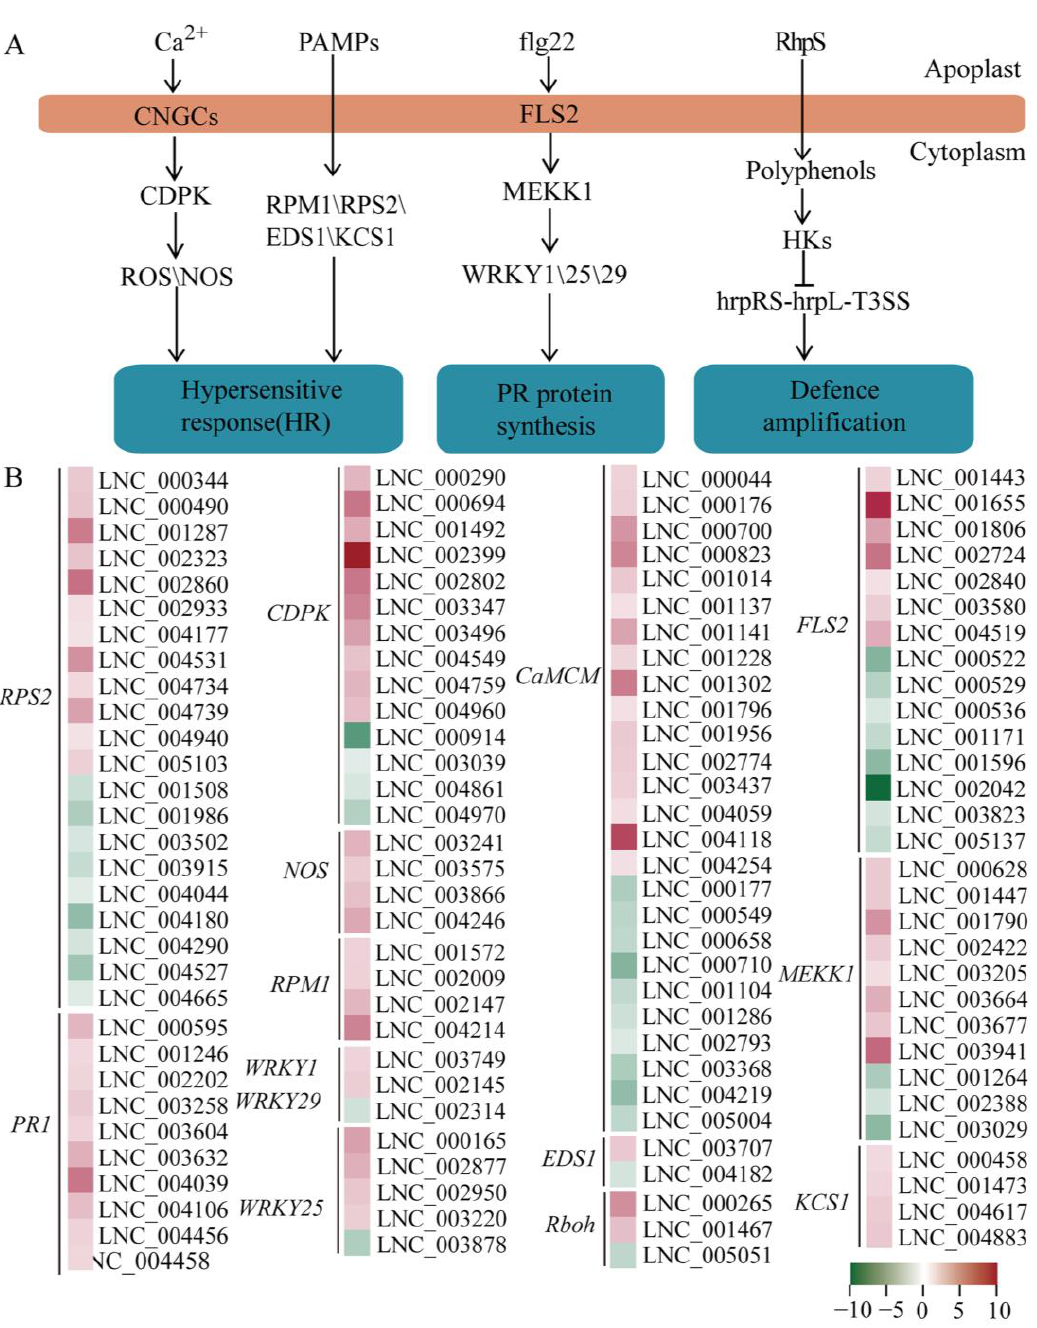
Figure 3. The pathway of plant-pathogen interaction. ( A ) A proposed model summarizing the main pathways for plant-pathogen interaction under UV-B radiation. ( B ) DELs involved in the pathway of plant-pathogen interaction were up-regulated under UV-B